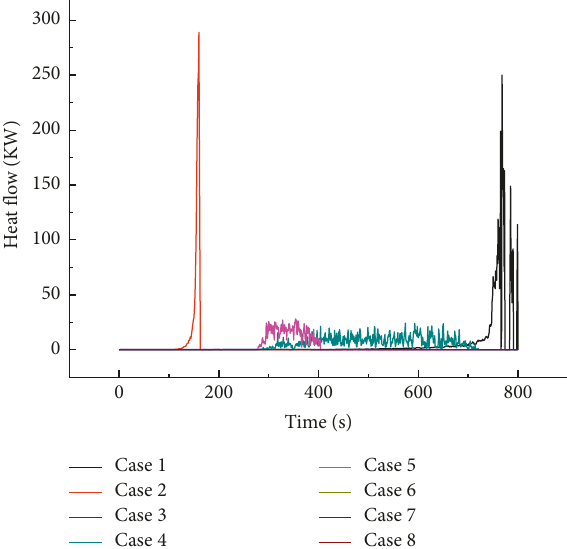
Figure 10: Temperature in case 8.